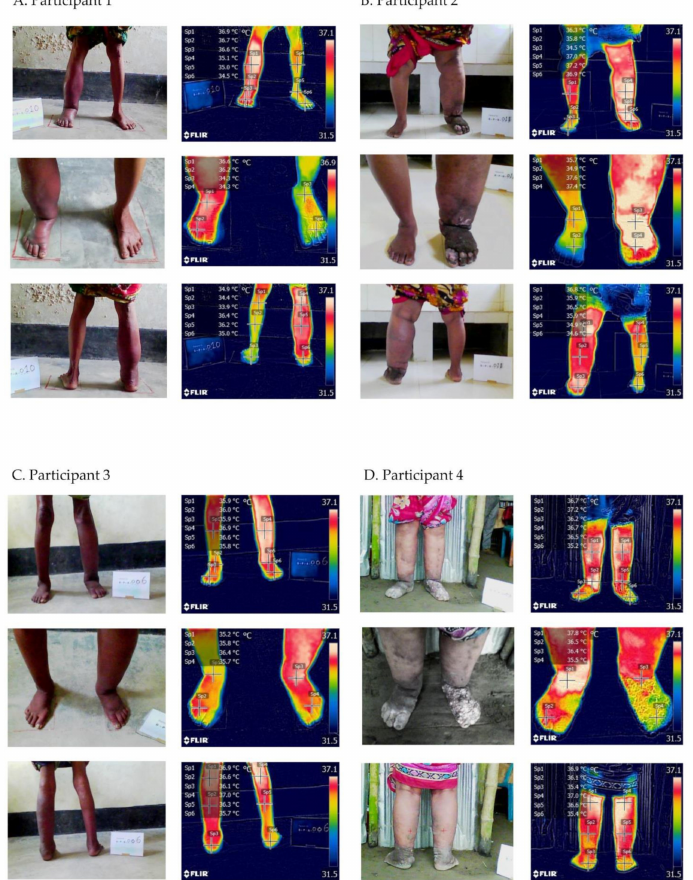
Figure 2. Cases studies–images and temperature measurements from four participants ( A – D ) with lymphoedema. Each participant had three images taken including the whole lower-leg (front and back), and a close-up image of the ankle and